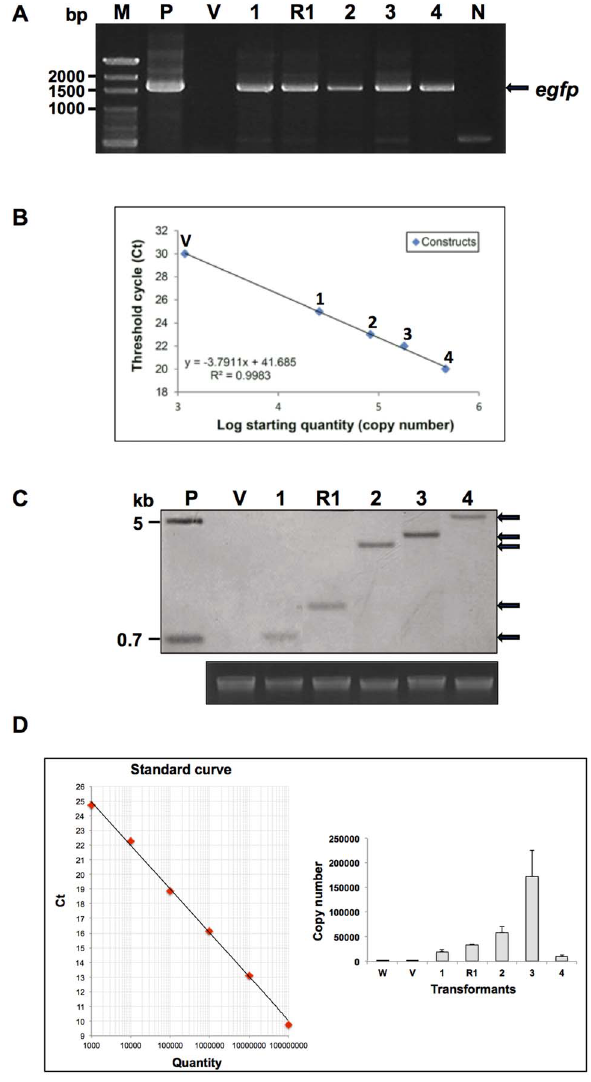
Figure 2. Analysis of nucleotides isolated from putative transformants. (A) PCR. (B) Real-time PCR. (C) Southern blot.